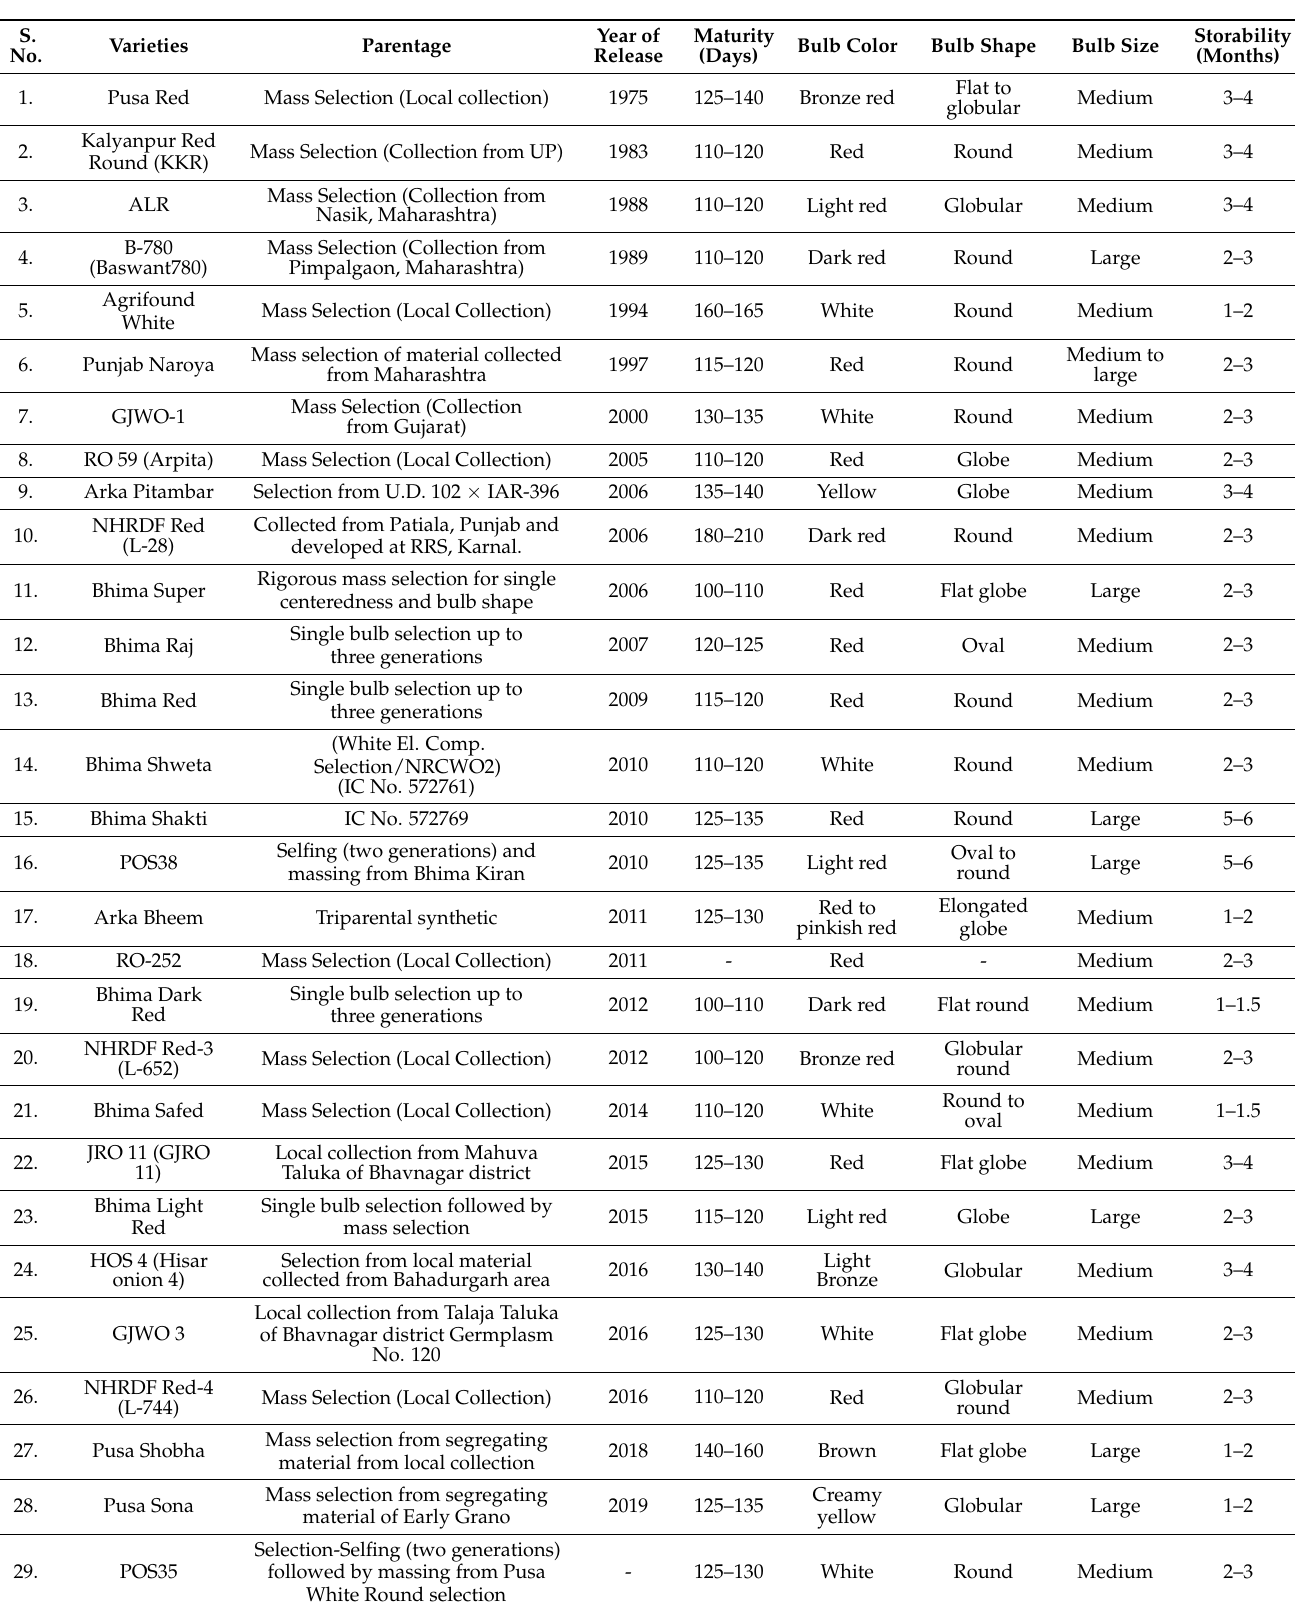
Table 1. Passport information of onion accessions collected for salinity tolerance